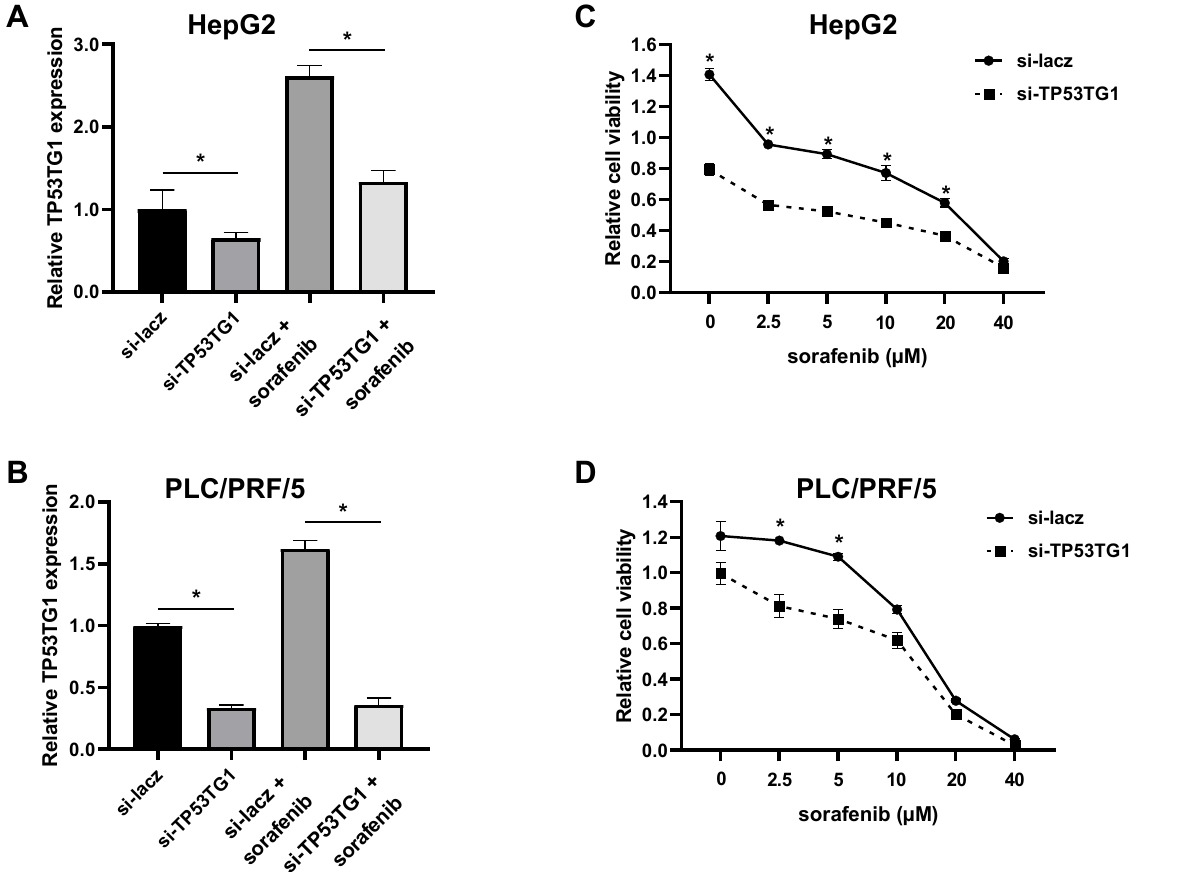
Figure 2. Knockdown of TP53TG1 enhances sensitivity of HCC cells to sorafenib. ( A , B ) RNA expression levels of TP53TG1 (normalized to 18S) in ( A ) HepG2 and ( B ) PLC/PRF/5 cells ( n = 3); ( C , D ) Cell viability of ( C ) HepG2 and ( D ) PLC/PRF/5 cells treated with different doses of sorafenib for 48 h ( n = 6). Error bars are shown as SEM, * p < 0.05.